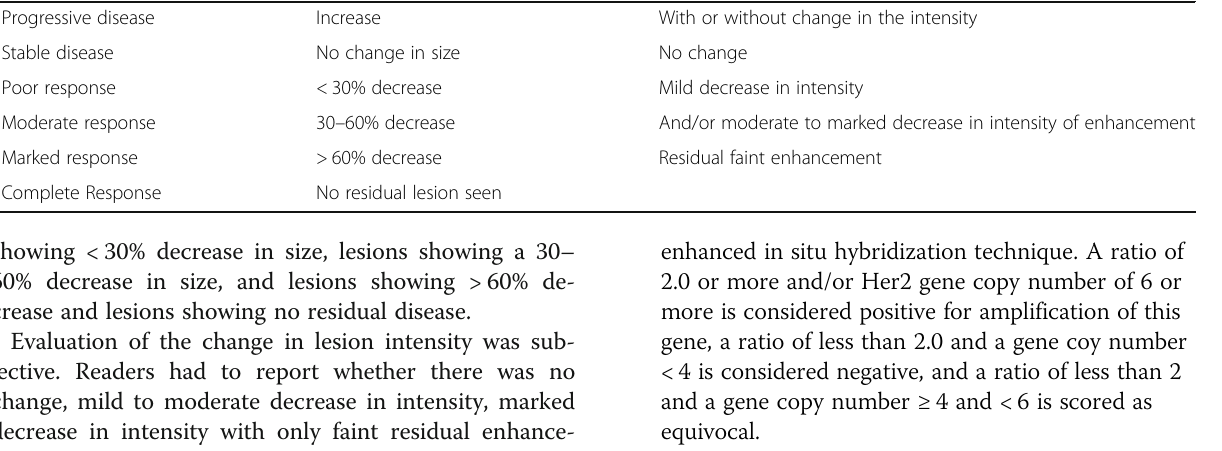
Table 1 The proposed combined evaluation Method Type of